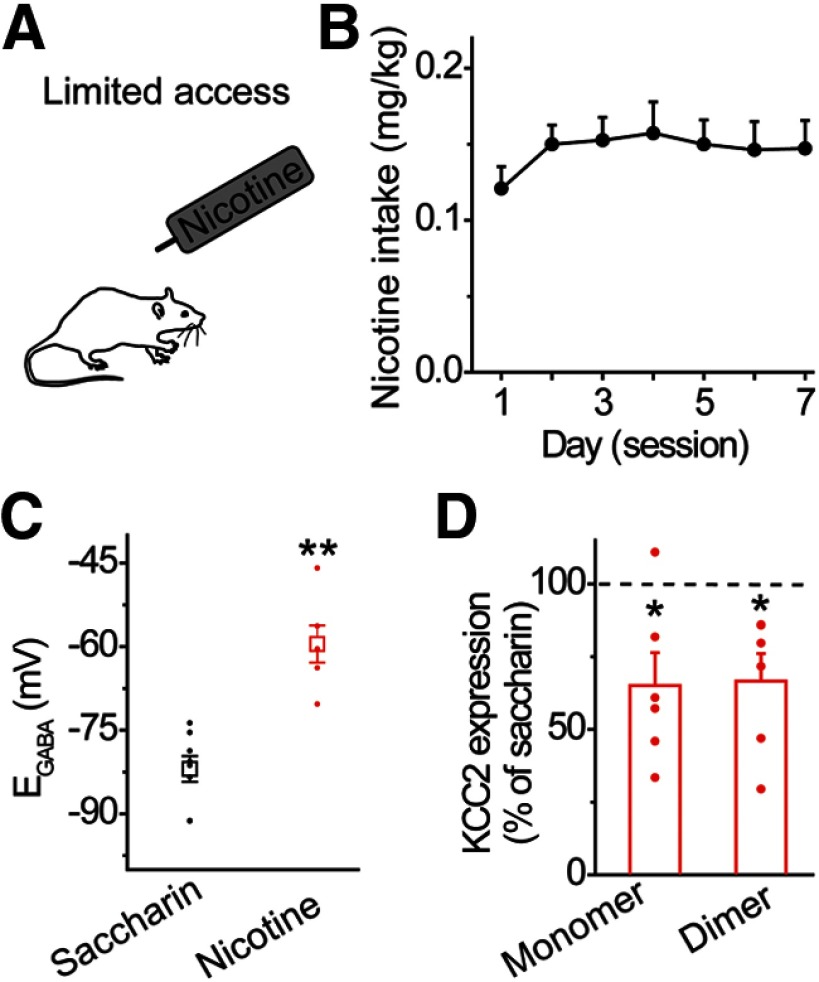
Nicotine consumption impairs chloride homeostasis in the VTA. A, Rats consumed a nicotine-containing saccharin solution for 1 h/d over the course of 7 d. B, Mean nicotine consumption during 1 h daily free-access sessions. Rats consumed 0.15 ± 0.01 mg/kg nicotine on average over the 7 d of limited access, n = 11 rats. C, VTA GABA neurons from nicotine-drinking (red) rats displayed a significantly depolarized EGABA relative to saccharin-drinking (black) rats; **p < 0.01, significantly different by t test, n = 6, n = 8 cells/group, n = 3 rats/group. D, Western blot analysis revealed that nicotine-drinking produced a significant reduction in KCC2 expression in the VTA relative to saccharin drinking rats (horizontal dashed line); *p < 0.05 significantly different by paired t test, n = 6 animals/group.